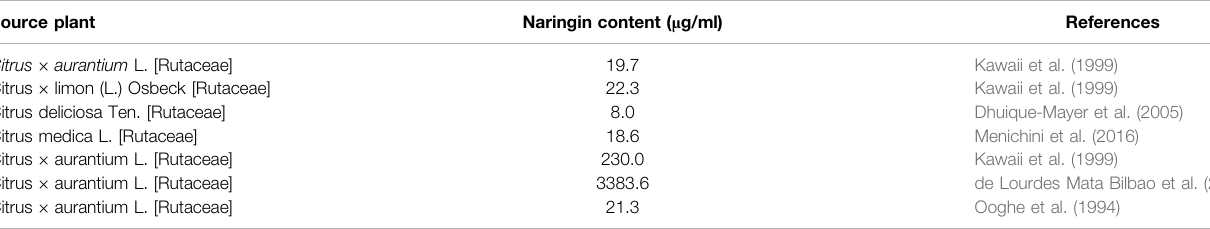
TABLE 2 | Description of population, intervention, comparator, outcome and study design (PICOS). Population (cid:129) Normal and cancer cell lines Intervention